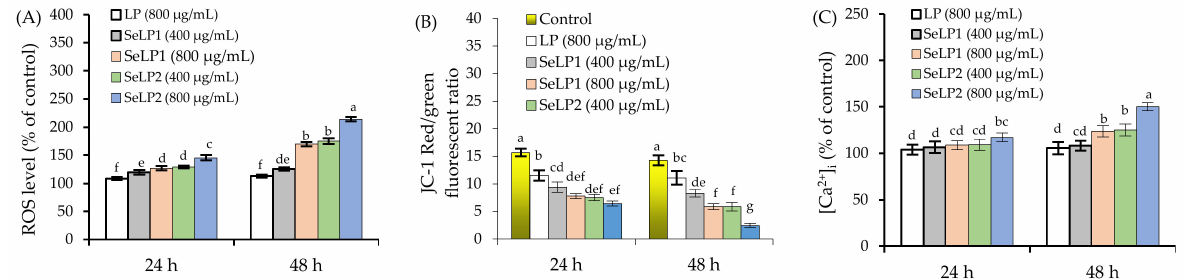
Figure 4. Effects of longan polysaccharides (LP) and selenylated polysaccharides (SeLP1 and SeLP2) on intracellular ROS ( A ), mitochondrial membrane potential (MMP) loss ( B ), and intracellular Ca 2+ ( C ) of HT-29 cells. Different lowercase letters above the columns indicate significant differences ( p <